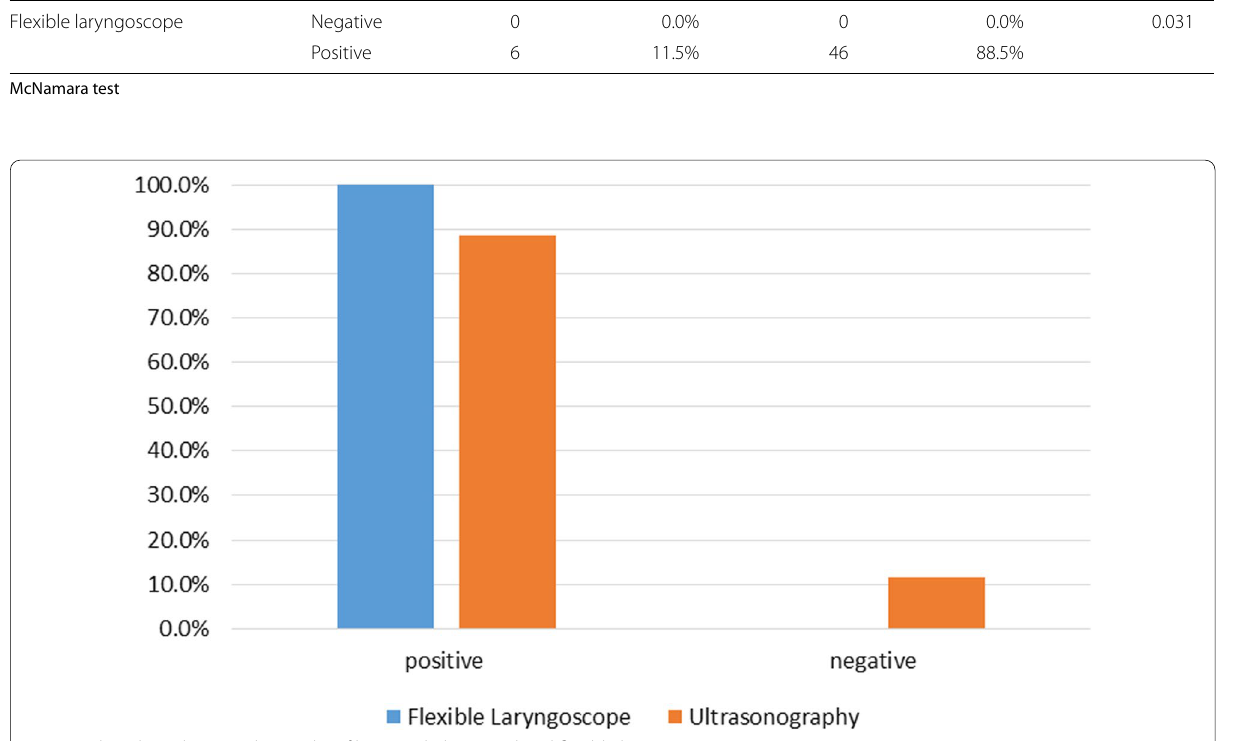
Fig. 3 A bar chart showing the results of laryngeal ultrasound and flexible